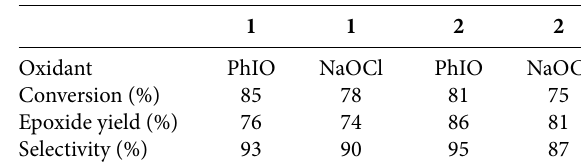
Table 4. Catalytic epoxidation results of complexes 1 and 2